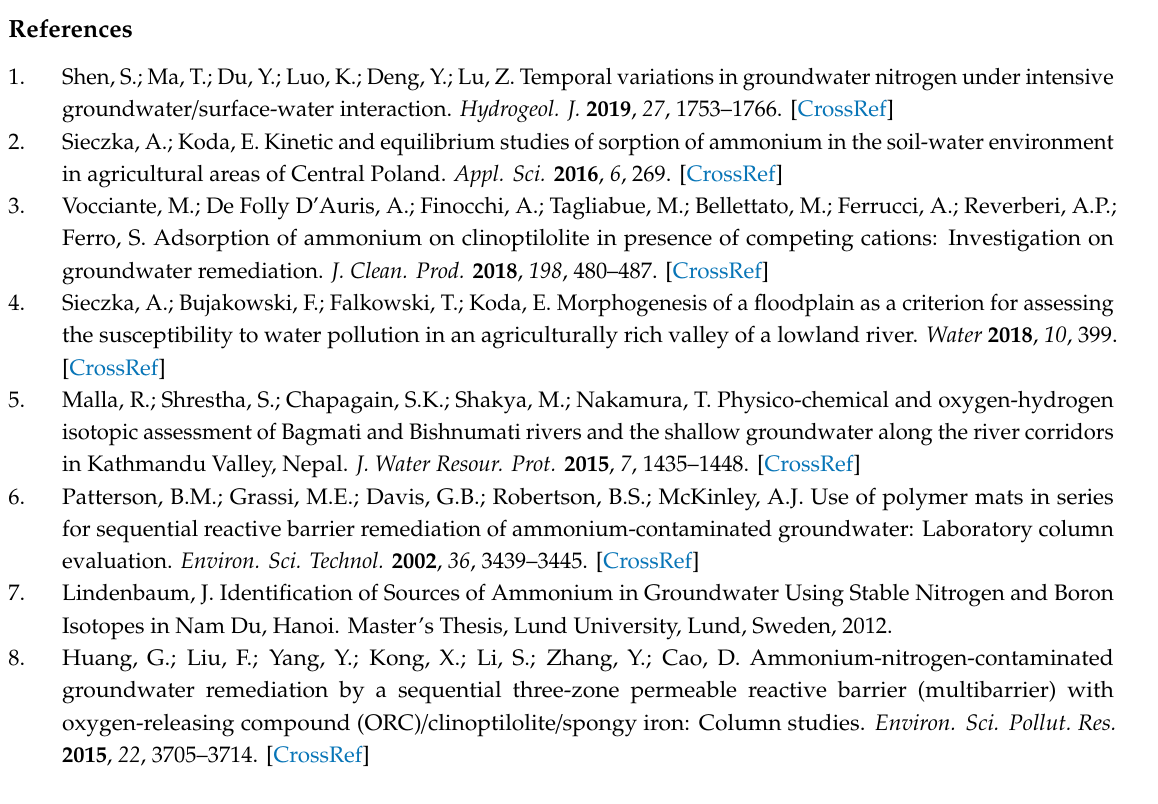
Figure S1: Schematic diagram of a dropping nitrification reactor, Figure S2: Zero-order (a) and first-order (b) kinetics for the decrease in NH 4 + -N along the single axis of the dropping nitrification units. NH 4 + -N concentrations represent the mean of four replicate reactors at di ff erent sampling depths. Comparison of the coe ffi cients of determination (R 2 ) between the zero- and first-order kinetic reactions (c), Table S1: Target genes for qPCR analysis, primers and sequences, annealing temperatures, and amplification